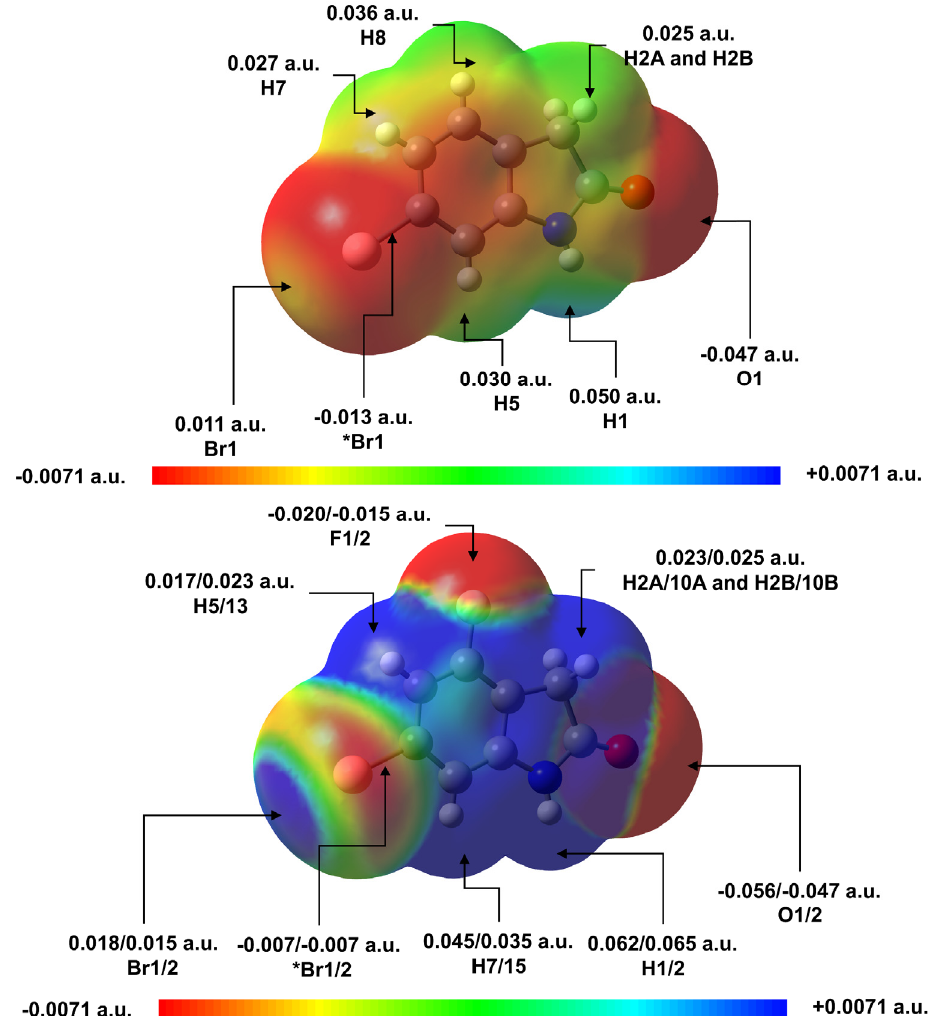
Figure 9. Molecular Electrostatic Potential (MEP) map for 1 , top, and 2a / 2b , bottom, calculated with the MP2/def2-TZVP theory level. The arrows indicate the interacting regions of the monomers that formed the dimers presented in Figures 4–6.